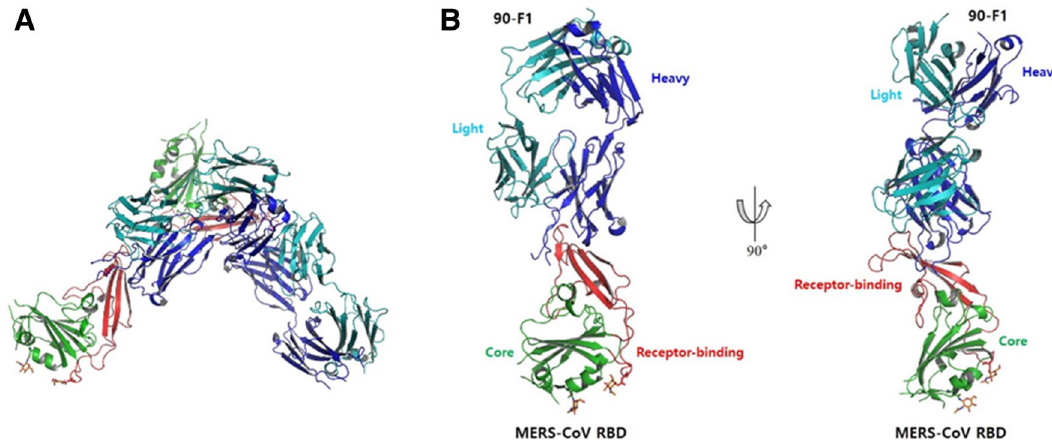
Figure 1. Crystal structure of MERS-CoV RBD complexed with KNIH90-F1 Fab. ( A ) Dimeric biological assembly of MERS-CoV RBD. Asymmetric unit containing a single RBD bound to a single KNIH90-F1 Fab to form a dimeric assembly. ( B ) The structure of MERS-CoV RBD complexed with KNIH90-F1 Fab. The complex comprises core/receptor-binding subdomains in the RBD and light/heavy chains of KNIH90-F1